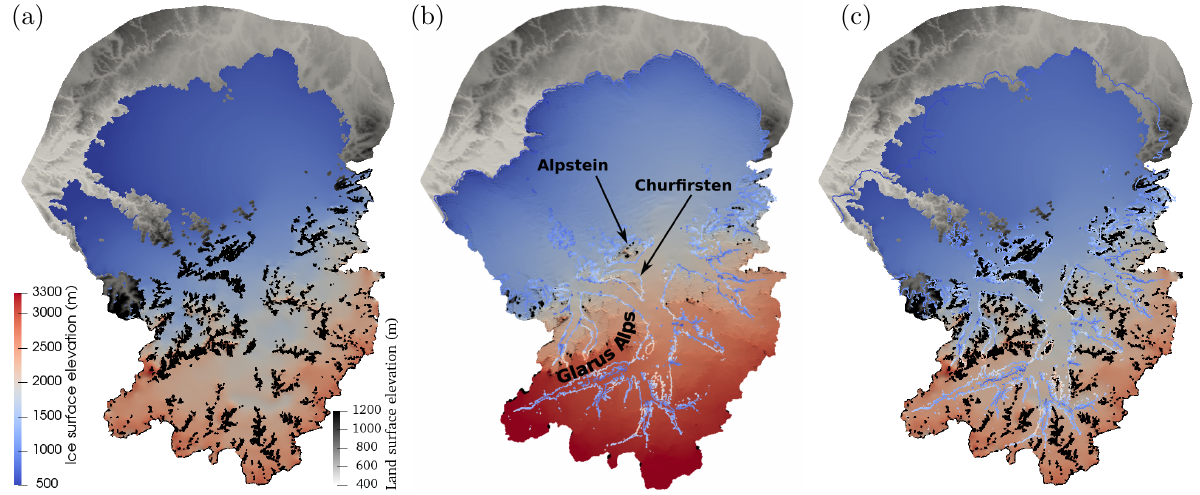
Figure 12. Comparison of geomorphic reconstruction with extent of temperate ice for simulation s5. (a) Geomorphic ice surface elevation of Benz-Meier (2003). Brown represents ice-free peaks above the ice surface; (b) ice surface elevation of simulation s5 with the contour line indicating the position of the temperate–cold transition along mountain flanks and colored according to elevation (same scale as ice surface). (c) Same as (a) with temperate–cold transition of (b) superimposed. All elevations are in